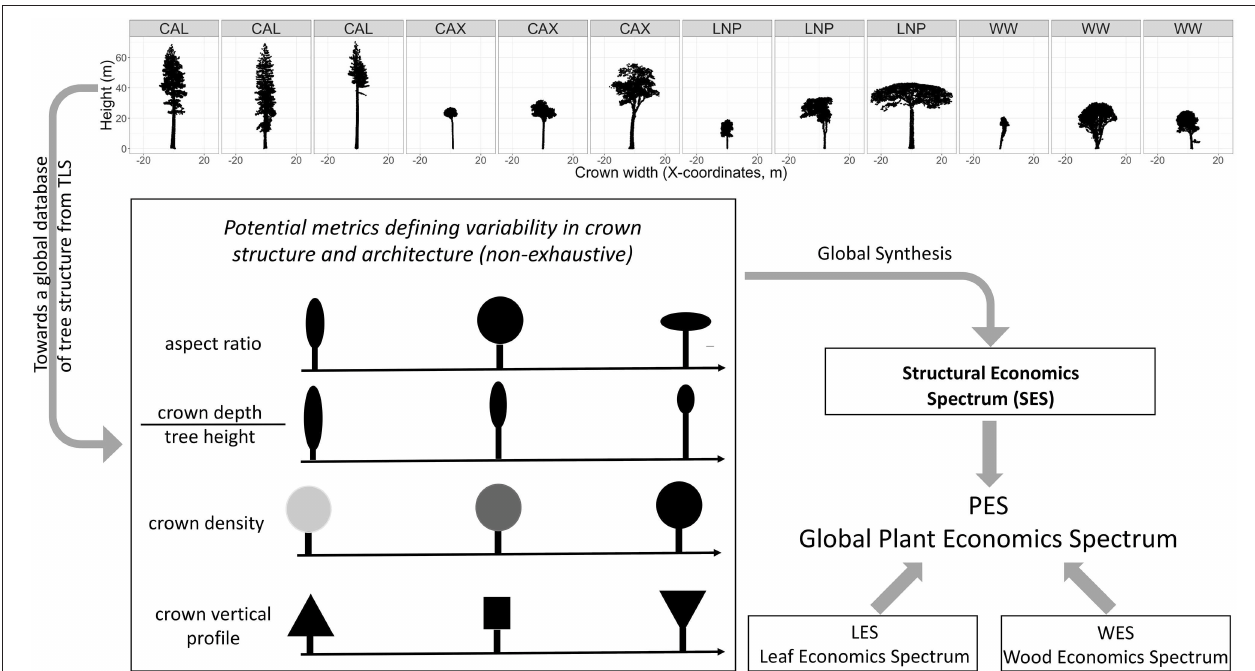
FIGURE 1 | Concept for the development of a structural economics spectrum. Top panel: examples of structural diversity of trees captured by TLS with scans from: CAL, Giant redwoods at Grove of Old Trees site ( Sequioa sempervirens ) California (US); CAX, diverse tropical rainforest tree species in Caxiuanã drought experiment control plot (Brazil); LNP, diverse tropical tree species at Lopé National Park (Gabon); WW, temperate Acer pseudoplatanus trees from Wytham Woods (UK). The redwood (CAL) and sycamore (WW) TLS scans illustrate within-species variability, while the scans of tropical trees (CAX, LNP) illustrate crown shape variability within a diverse tropical forest plot of one hectare in Lopé and Caxiuanã. The bottom panel illustrates that a series of structural metrics could be synthesized in a low dimensionality space which defines the SES. The SES can potentially be integrated with the LES and WES into the